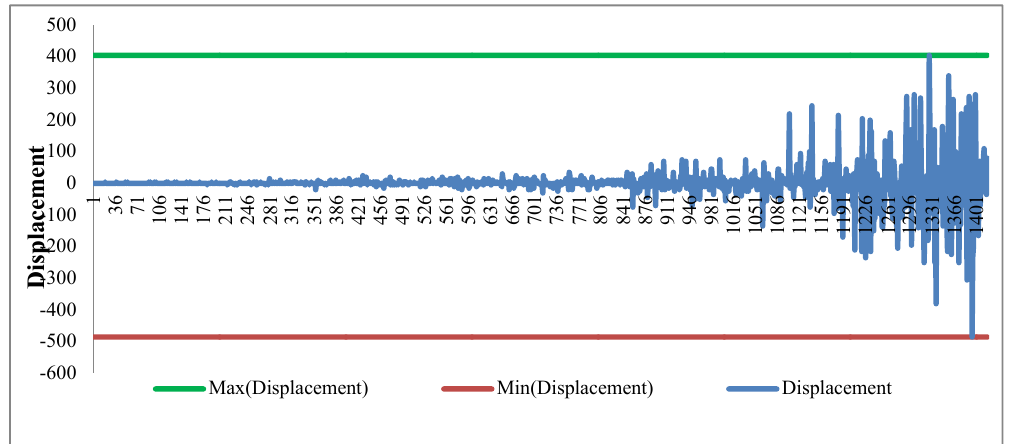
13 of 19 Figure 7. Displacement while weights set as [0,1,0] in test 2. Figure 8. Difficulty of every slot allocation while weights set as [0,1,0] in test 2. 